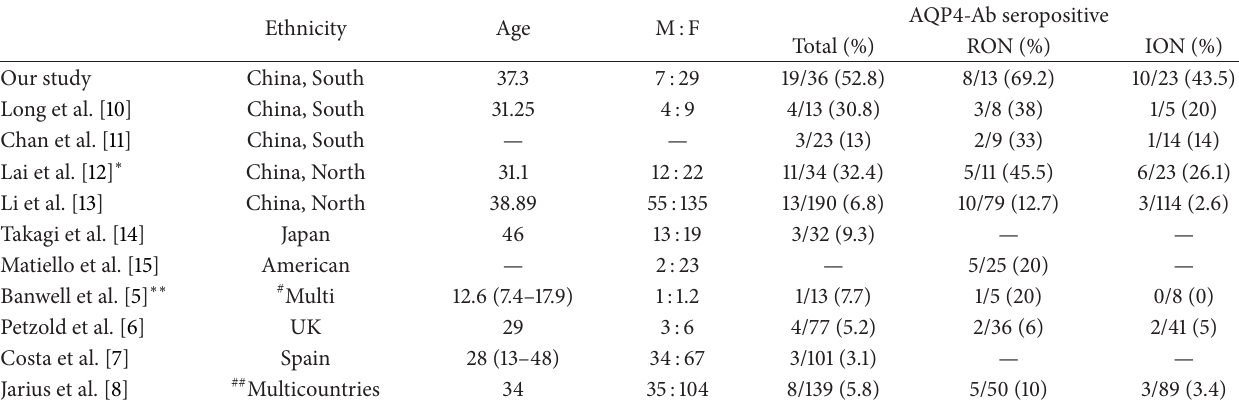
Table 3: Frequency of AQP4-Ab in ON among different